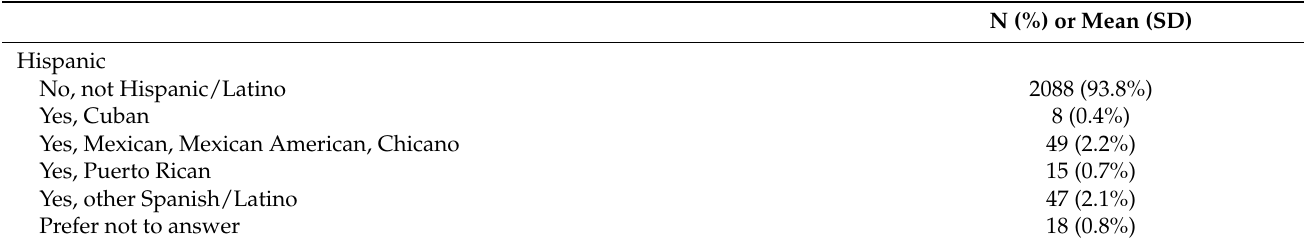
Table 1. Overall sociodemographic characteristics for all respondents ( n =